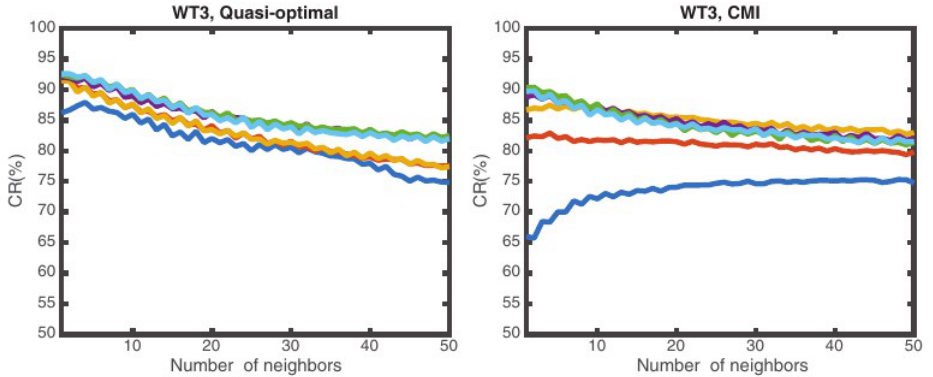
Figure 5. Effect of the number of neighbors for WT1 and WT3. Each colored curve corresponds to a specific number of features, from 1 to 6. Only the QO and the CMI feature selection algorithms are reported